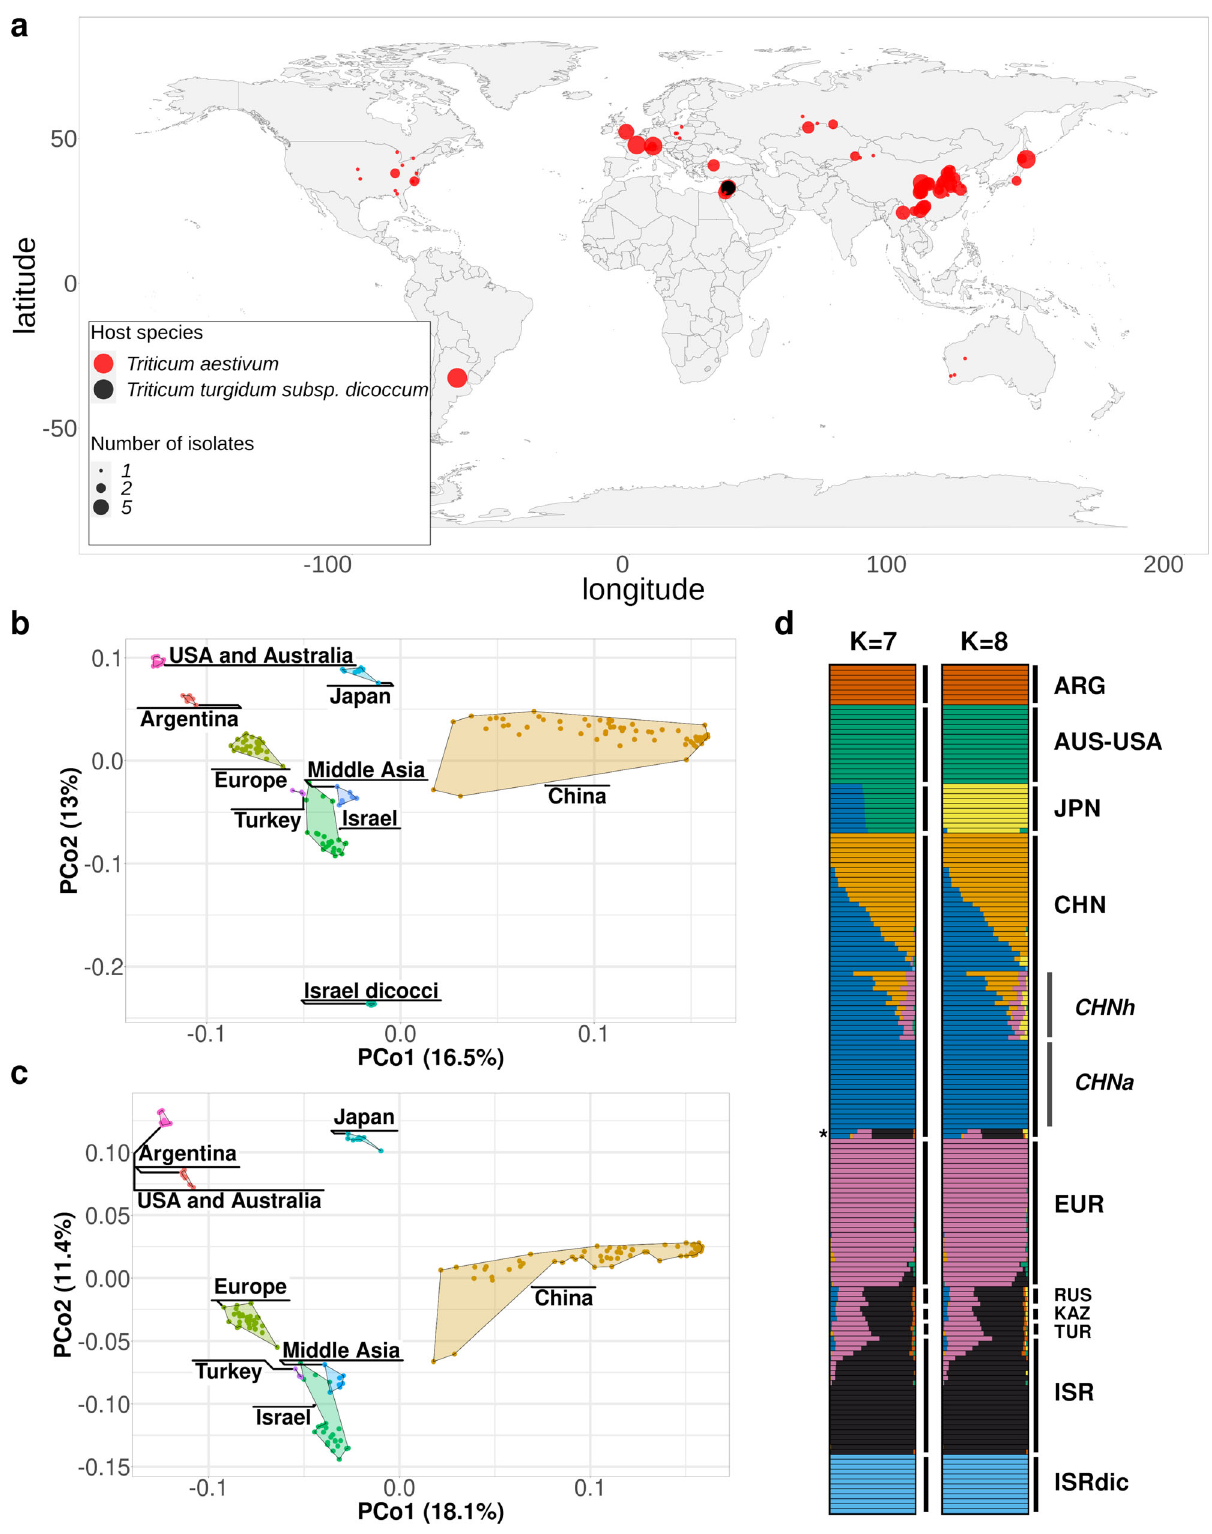
Fig. 1 Basic information about the wheat powdery mildew isolates. a World map with points where the isolates were collected from. The color corresponds to the host where the isolates were isolated and the size of the dot corresponds to the number of isolates collected at that place. b PCoA analysis plot using simple mismatch distances of LD-pruned SNPs of the 172 isolates with the principal components 1 and 2 including the B.g. dicocci forma specialis . c PCoA analysis plot using simple mismatch distances of LD-pruned SNPs of the 160 isolates with the principal components 1 and 2, excluding B.g. dicocci . d Admixture plot for ancestral populations with the two most probable numbers of K = 7 and K = 8 for the 172 isolates with LD-pruned SNPs with a minor allele frequency >0.1. The asterisk indicates two isolates from China with ancestry from the Fertile Crescent.